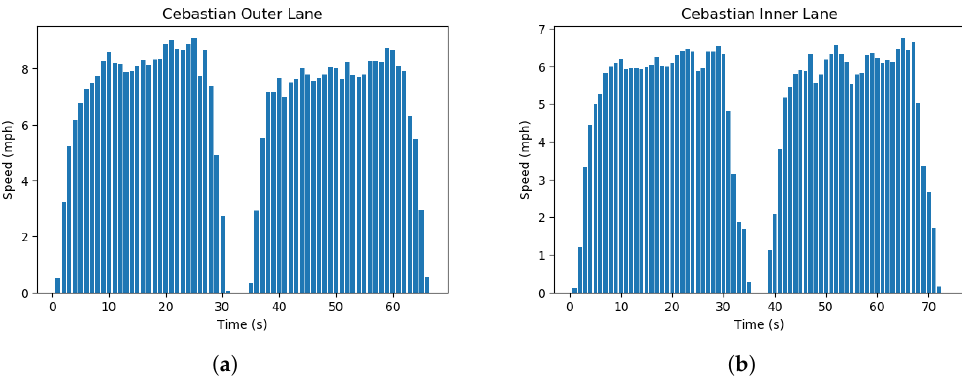
The graphs to evaluate human driving are given below.